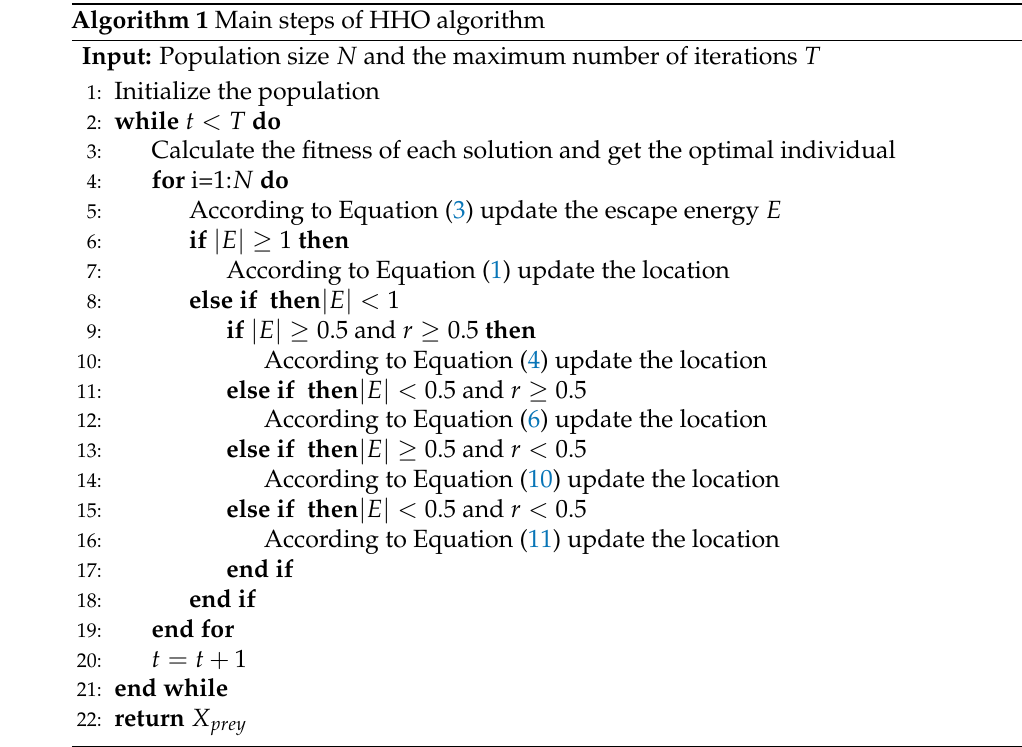
Algorithm 1 Main steps of HHO